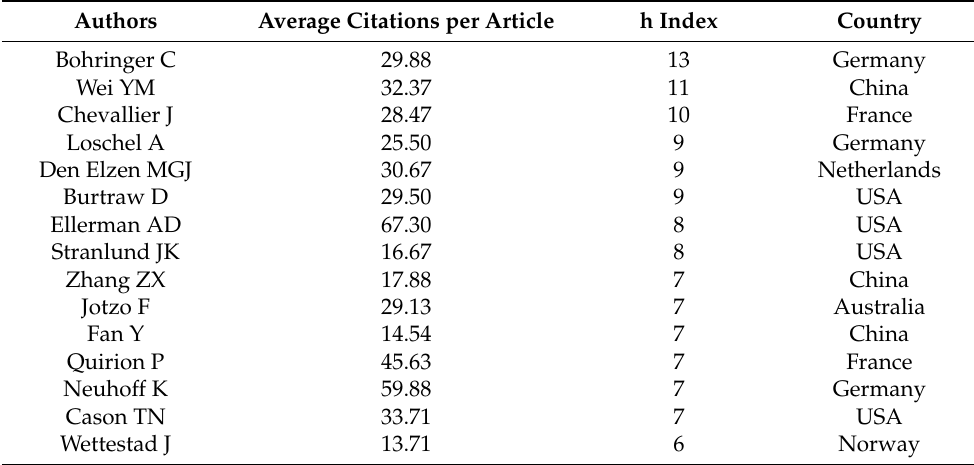
Table 3. The top 15 most productive